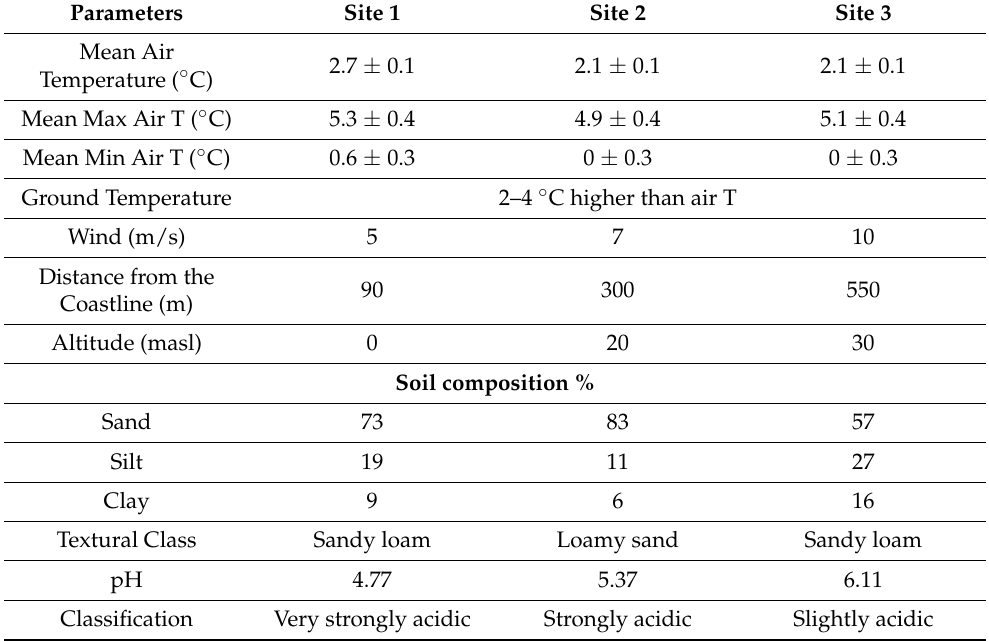
Table 1. Characteristics of the three sampling